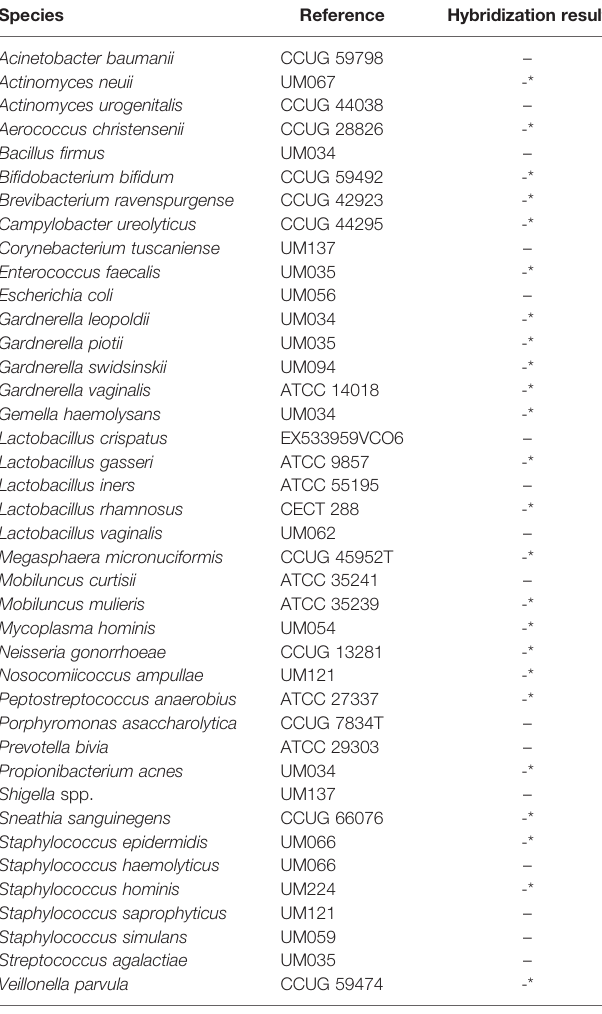
TABLE 2 | Hybridization of F. vaginae probe with different species for determination of analytical speci fi city. Species